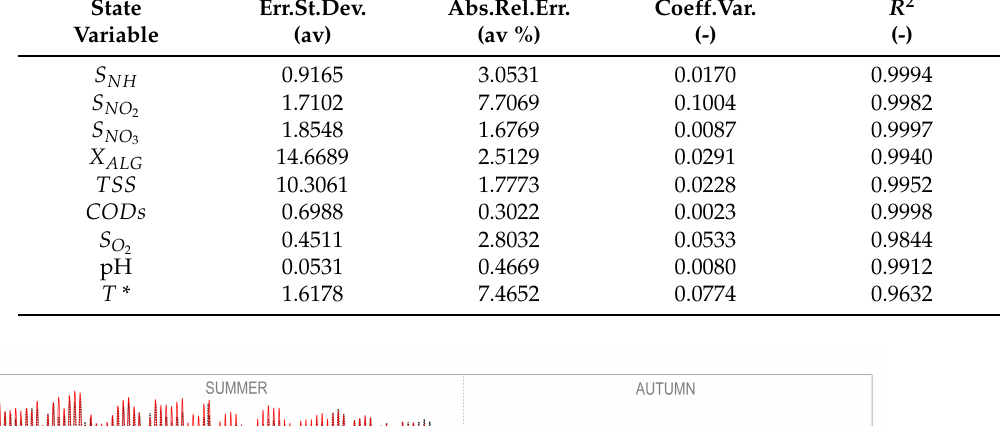
Table 1. Comparison between simulated variables using temperature measurement and predictions from the full predictive model. (*): for temperature, the comparison is between the measured and simulated temperatures. State Err.St.Dev. Abs.Rel.Err. Coeff.Var.